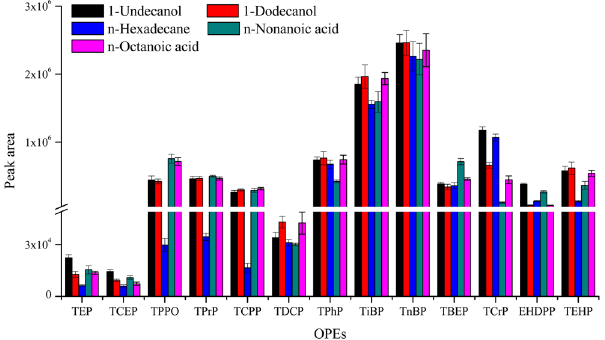
Figure 1. The efficiency of different extraction solvents on the extraction of OPEs from aqueous samples (n =